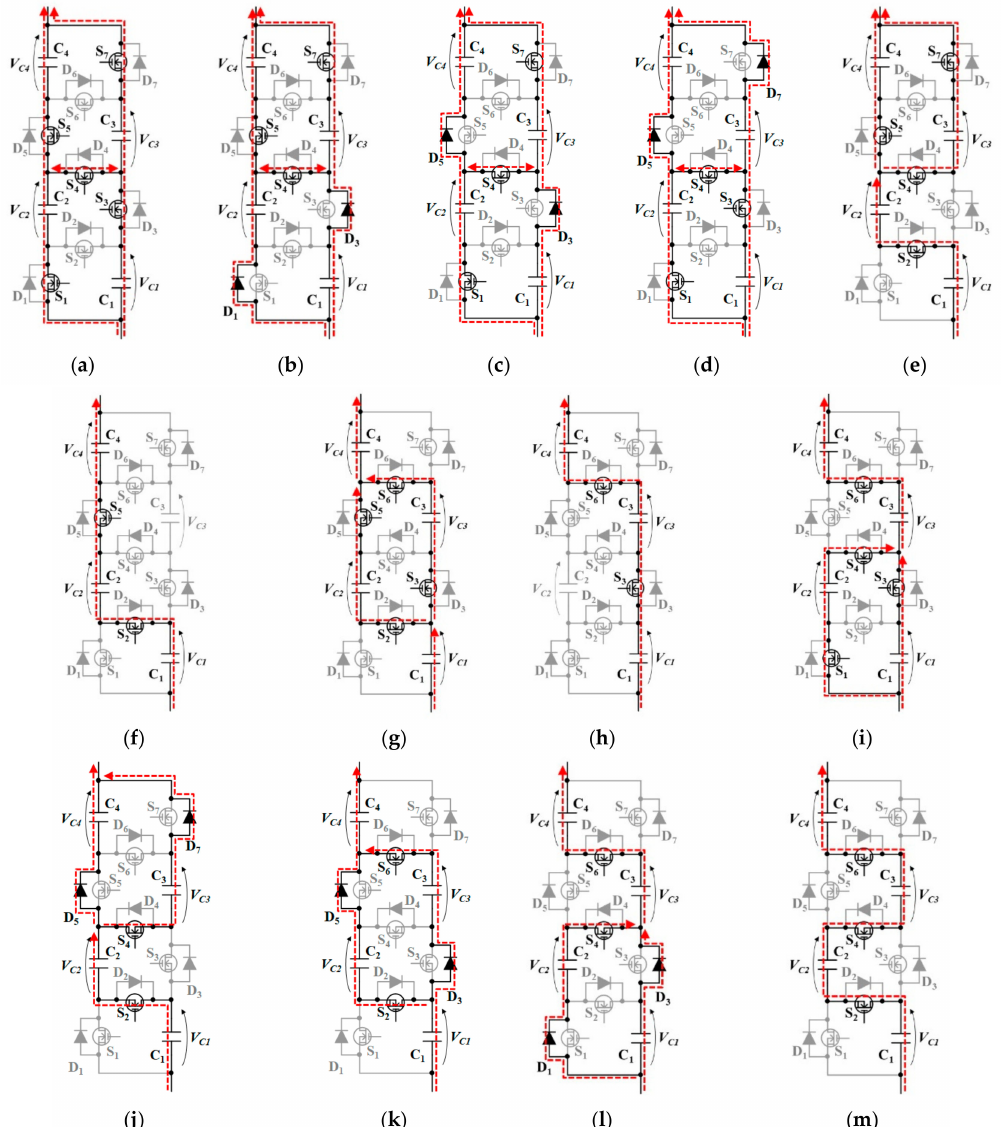
Figure 11. Mode transitions in the discharging process: Current flow paths in ( a ) Mode 1, ( b ) dead time between Mode 1 and sub-Mode A, ( c ) dead time between Mode 1 and sub-Mode B, ( d ) dead time between Mode 1 and sub-Mode C, ( e ) sub-Mode A, ( f ) dead time between sub-Modes A and B, ( g ) sub-Mode B, ( h ) dead time between sub-Modes B and C, ( i ) Mode C, ( j ) dead time between sub-Mode A and Mode 3, ( k ) dead time between sub-Mode B and Mode 3, ( l ) dead time between sub-Mode C and Mode 3, and ( m ) Mode